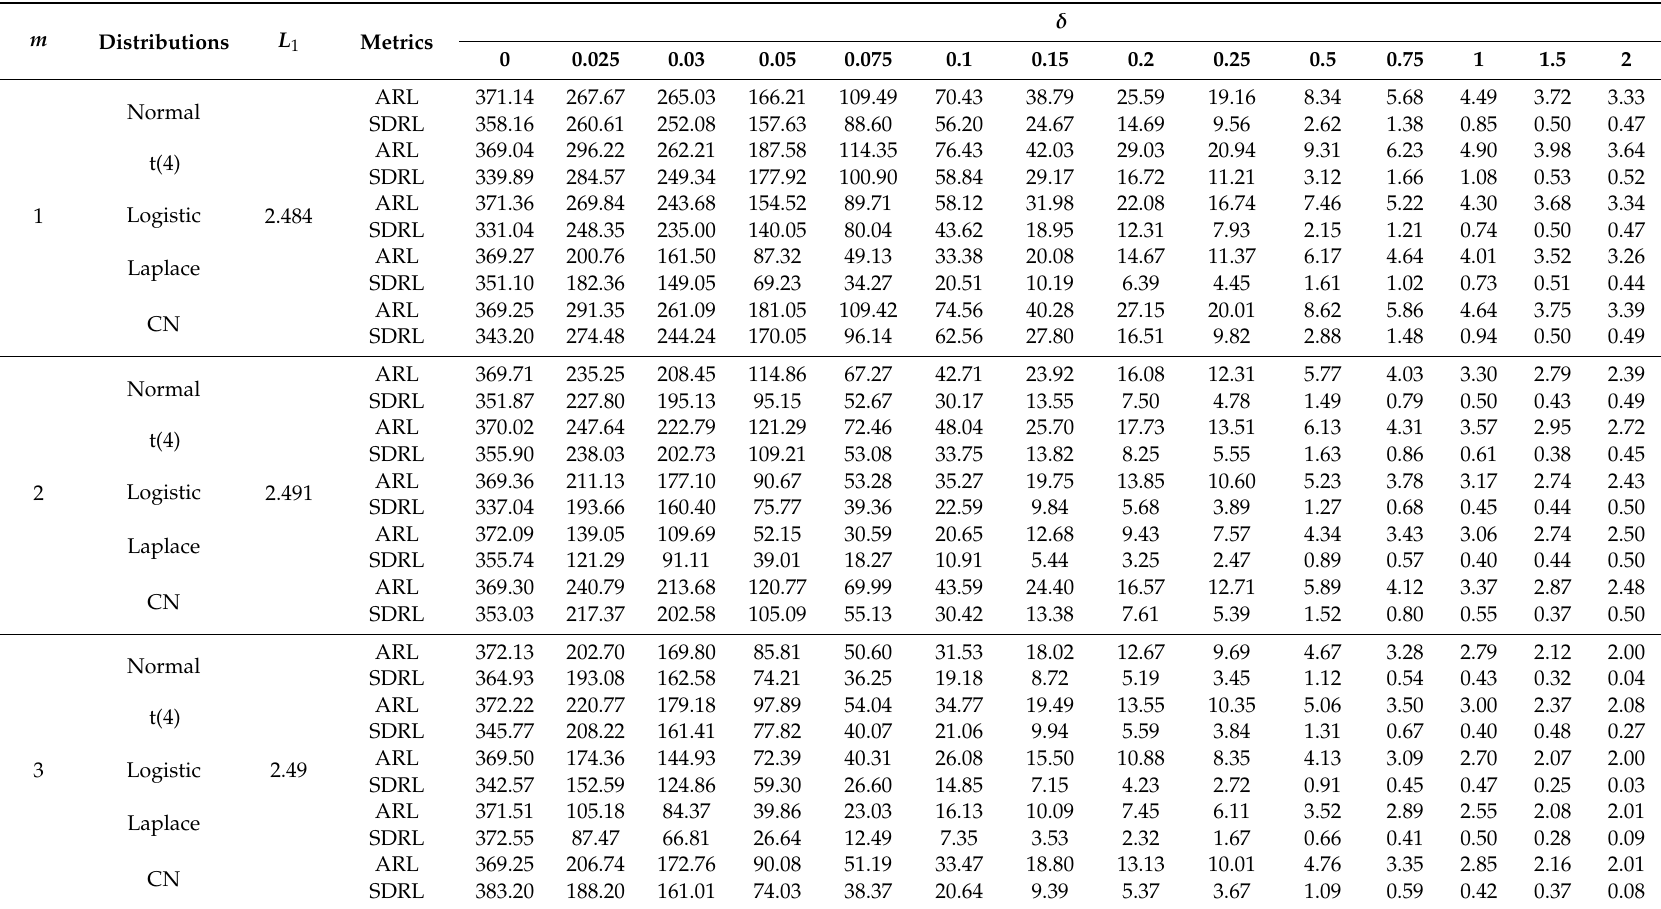
Table 6. OOC RL profiles of the proposed chart under di ff erent continuous distribution at λ = 0.05 and n =